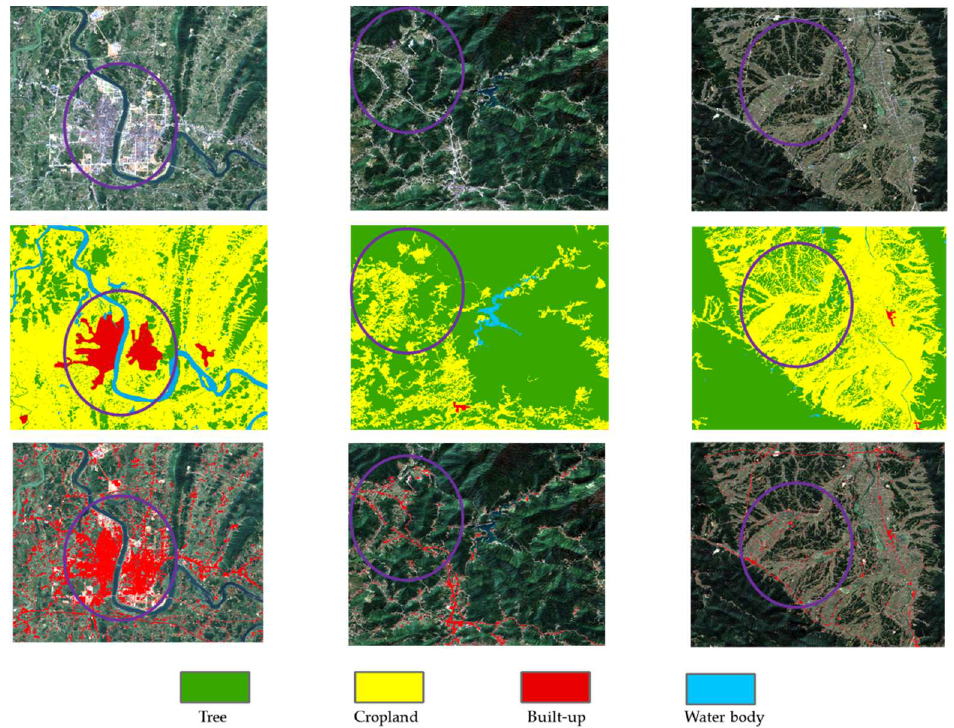
Figure 7. Comparison of mapping effects. First row: Sentinel-2 L2A image; second row: Globeland30 30 m landcover; third row: our results. First column: urban area; second column: forest area; third column: farmland area.